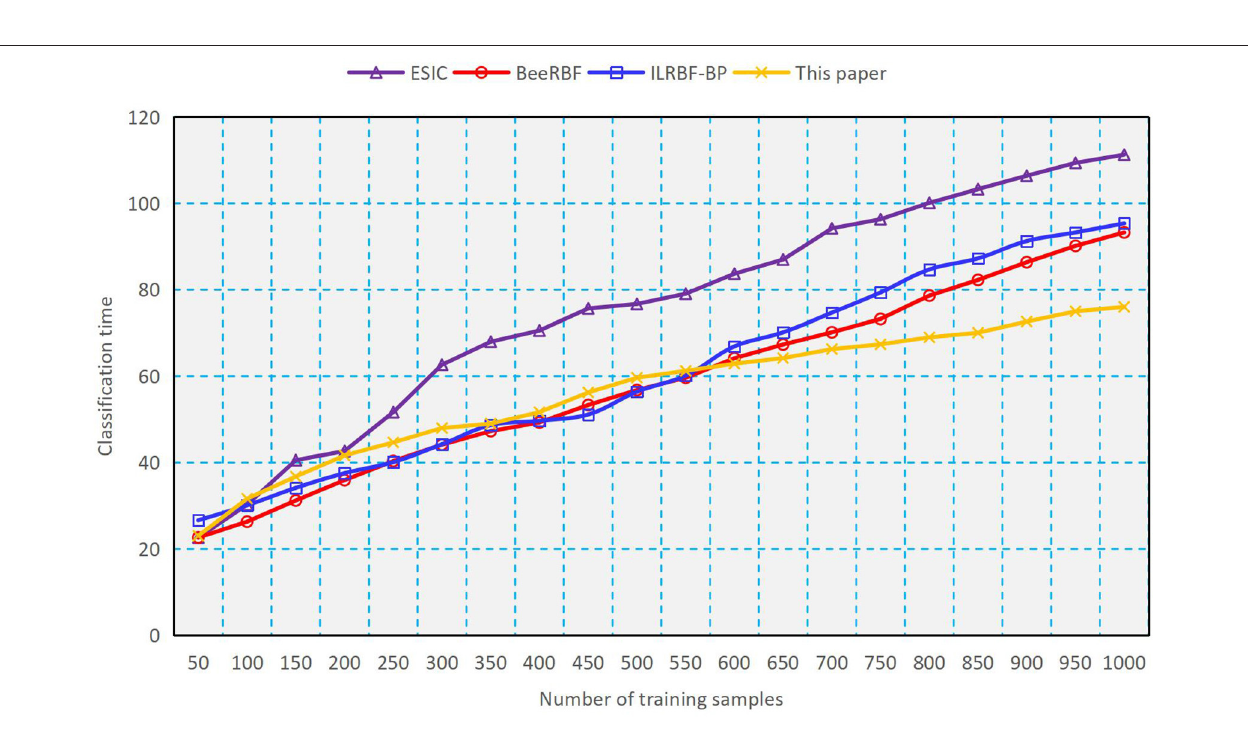
FIGURE 3 | Performance of classification